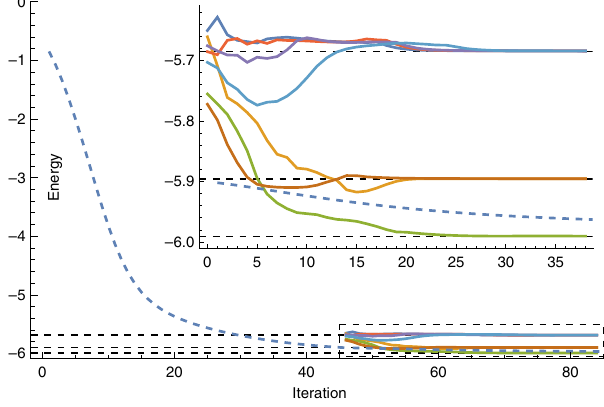
FIG. 8. Using root finding to explore a low-energy subspace of a ten-qubit spin chain via an Ansatz circuit of 20 layers ( ν ¼ 610 ). The initialization to the low-energy subspace is performed by imaginary time evolution (blue, dashed line) and is followed by runs of CoVaR to find the three lowest eigenstates (marked by dashed lines), to an accuracy of Δ E ≤ 4 × 10 − 4 in all cases. Imaginary time evolution is run for 250 iterations after the point where root finding starts and converges to a state with Δ E ¼ 0 . 012 . These simulations do not include shot